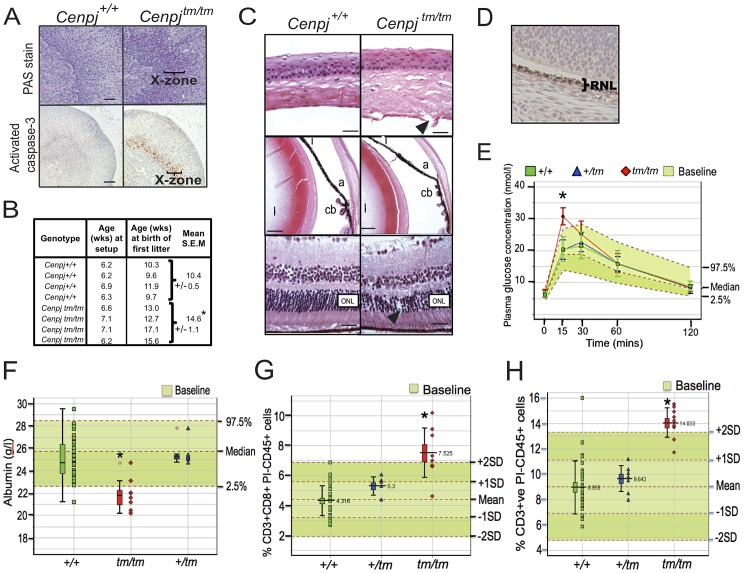
Delayed onset to puberty and ocular, endocrine, haematological, and plasma abnormalities.A. Periodic acid-Schiff (PAS) staining and cleaved (activated) caspase-3 immunostaining of adrenal sections from 16 week-old virgin female Cenpjtm/tm mice (n = 3) confirmed corticomedullary pigmentation and ongoing apoptosis in the X-zone, respectively (representative images, scale bars 100 µm). B. Breeding records of Cenpjtm/tm females set up with Cenpjtm/tm males at 6–7 weeks of age showed that Cenpjtm/tm females produce their first litter around four weeks later than Cenpj
+/+ females. *P = 0.012, t-test. C. Top panel shows normal cornea from a Cenpj
+/+ mouse. Cenpjtm/tm mice had disruption of the Descemet's membrane and corneal endothelium (arrow). Middle panel shows normal anterior segment from a Cenpj
+/+ mouse. The angle was displaced anteriorly in eyes from Cenpjtm/tm mice and ciliary process morphology was abnormal. (a, angle; i, iris; cb, ciliary body; l, lens). Bottom panel shows normal retina from a Cenpj
+/+ mouse eye. The retina photoreceptor cells of Cenpjtm/tm mice were reduced in number and showed columnar disorganized (arrow). (ONL, outer nuclear layer). D. Immunohistochemical staining for Cenpj in Cenpj
+/+ embryo eye (E14.5; RNL retinal neuroblast layer). E. Intra-peritoneal glucose tolerance test to show that female Cenpjtm/tm mice have a 15 minute delay in response to glucose challenge (n = 4 Cenpjtm/tm vs. n = 32 Cenpj
+/+, *P = 2×10−5, t-test). Graph also shows n = 9 Cenpjtm/+ and n = 670 baseline wildtype controls. F. Plasma albumin levels were decreased in Cenpjtm/tm males (n = 8 Cenpjtm/tm vs. n = 35 Cenpj
+/+, *P = 4.9×10−5, t-test). Graph also shows n = 7 Cenpjtm/+ and n = 768 baseline wildtype controls. G. Flow cytometric analysis of peripheral blood leukocytes in Cenpjtm/tm mice revealed an increase in the number of CD8+CD3+ and H. total CD3+ cells. Data shows total counts per 30 000 propidium-iodide (PI) negative, CD45-positive cells from male mice. For n = 9 Cenpjtm/tm vs. n = 30 Cenpj
+/+: CD3+CD8+ *P = 0.0002 and CD3 *P = 2.9×10−5, Mann-Whitney-Wilcoxon test. Graphs also show n = 7 Cenpj
+/tm and n = 356 baseline wildtype controls. For all ‘Box and Whisker’ plots, the lower whisker extends to the lowest datum still within 1.5 Inter-quartile range (IQR) of the lower quartile. The upper whisker extends to the highest datum still within 1.5 IQR of the upper quartile.